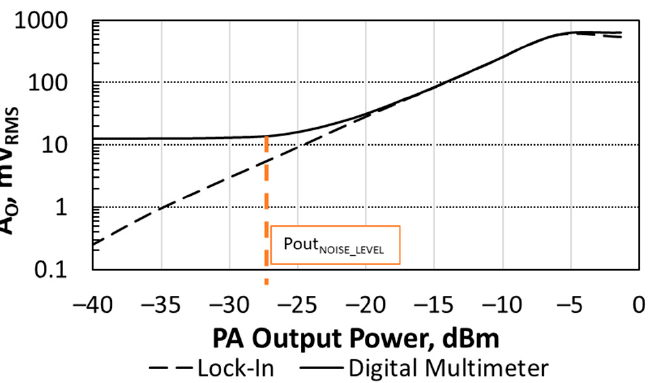
Figure 11. Sensors output voltage amplitude as a function of the output power delivered by the CUT to the load. Measurements obtained with a LIA and a DMM in AC mode . Label indicates at which P OUT the DMM readings reach the noise level.